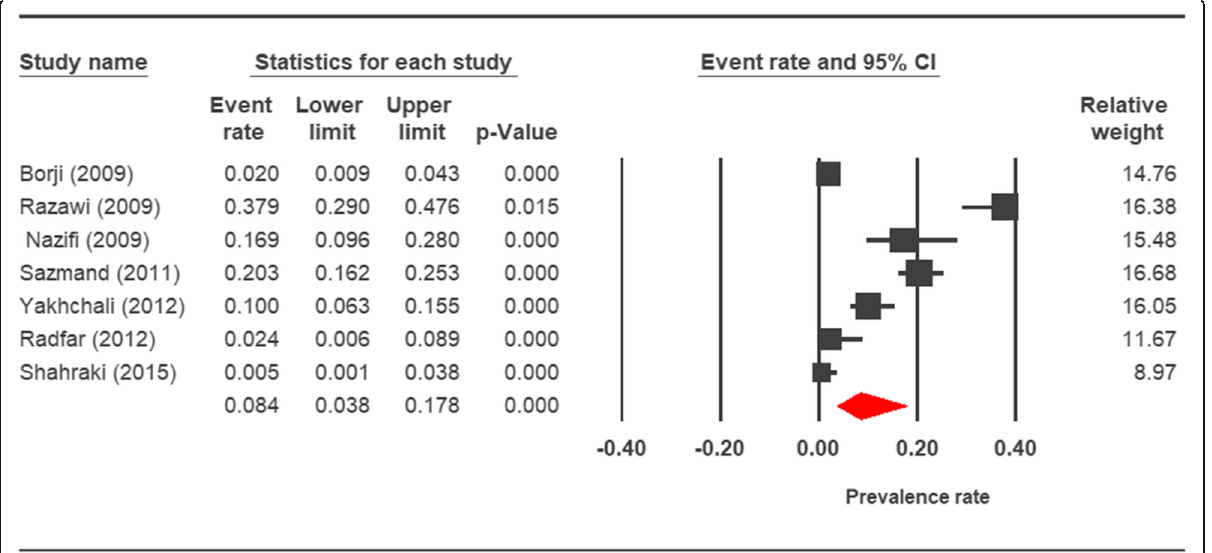
Fig. 5 Forest plot diagram showing the prevalence rate of Cryptosporidium infection in camels of Iran